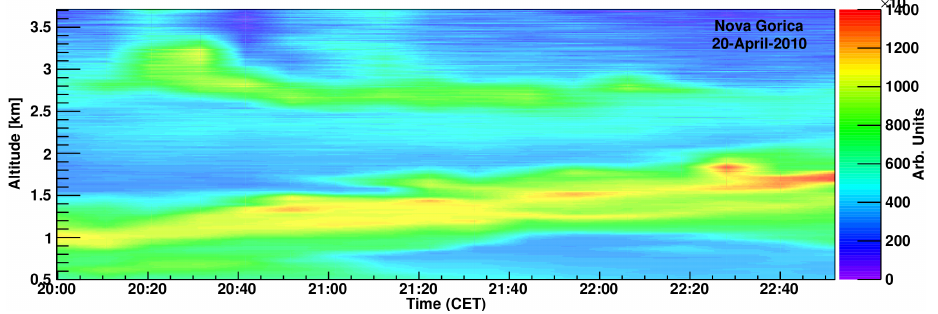
Fig. 4. Temporal variation of aerosol layers over Nova Gorica between 20:00 – 22:50 CET on 20 April 2010 in terms of 1064-nm range-corrected lidar signal (arbitrary units). Two elevated aerosol layers can be clearly seen during the measurement, which are at altitudes of 1.0–1.5km and 2.5–3.0km, respectively.